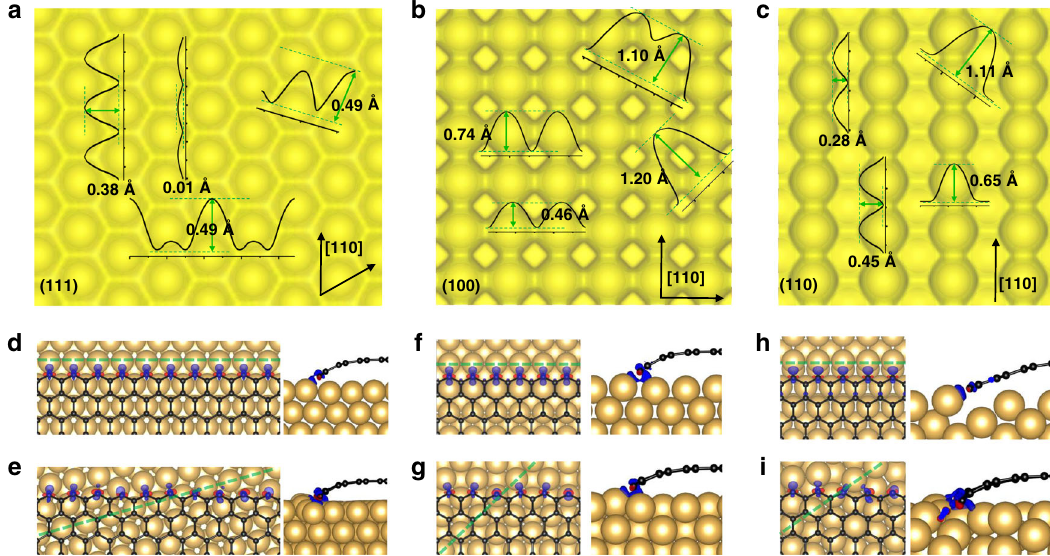
Fig. 2 Charge density analysis of low-index Cu surfaces and zigzag edges of graphene adsorbed on them with different orientations. a – c The electron density pro fi les with isovalue of 0.03 Bohr − 3 of Cu(111), Cu(100), and Cu(110) surfaces, respectively. The height of the isosurface along different directions of the different Cu surfaces are shown. The Cu[110] directions on these surfaces are also marked. d – i Charge density differences with isovalue of 0.01 Bohr − 3 of graphene on Cu(111)/Cu(100/Cu(110)) surfaces with misorientation angles of 0 o d , f , h and 15.3 o /45 o /35.3 o e , g , i . Blue and red colors in d – i represent electron accumulation and depletion, respectively.